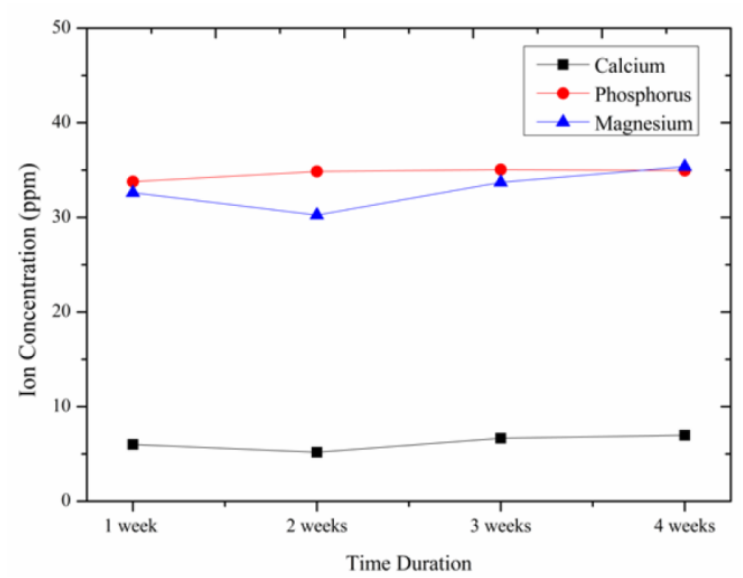
Figure 8. Change in ionic concentration.